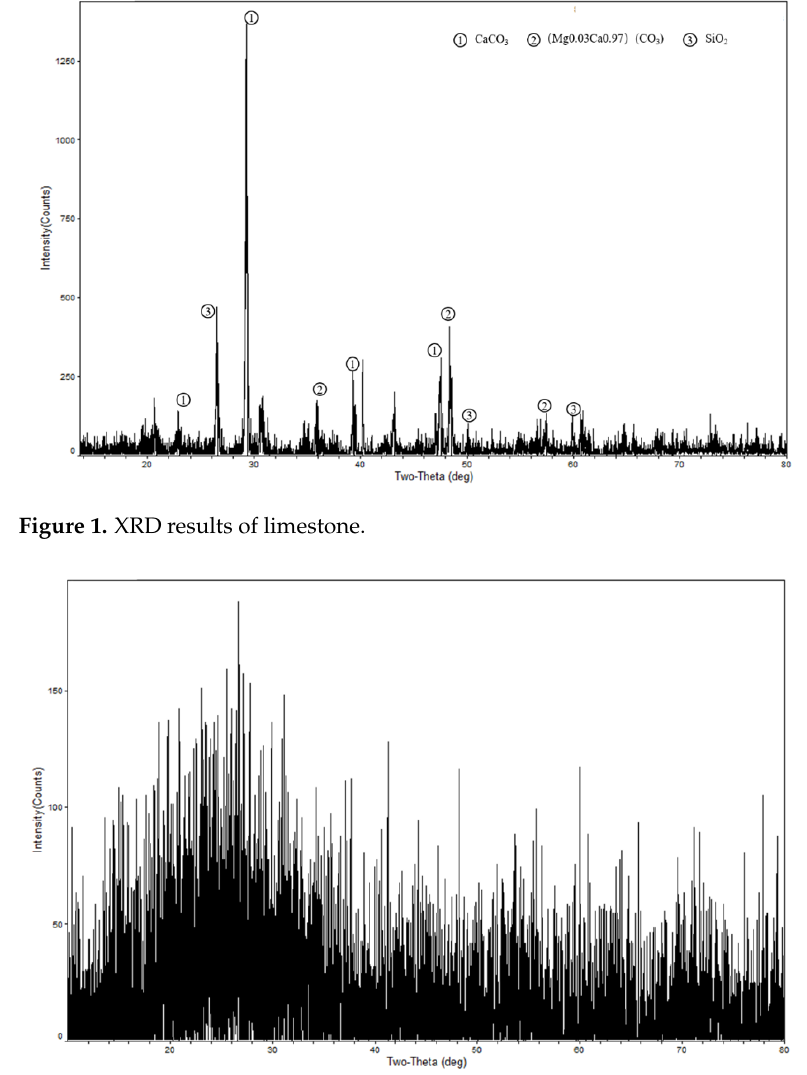
Figure 3. XRD results of ceramics.